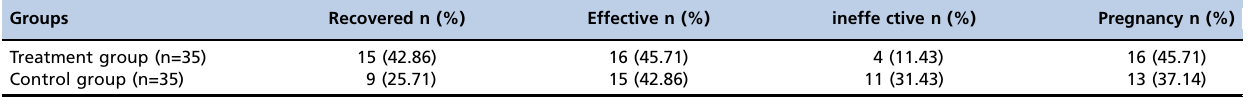
Table 4 - Menstruation and pregnancy at 6 months after the